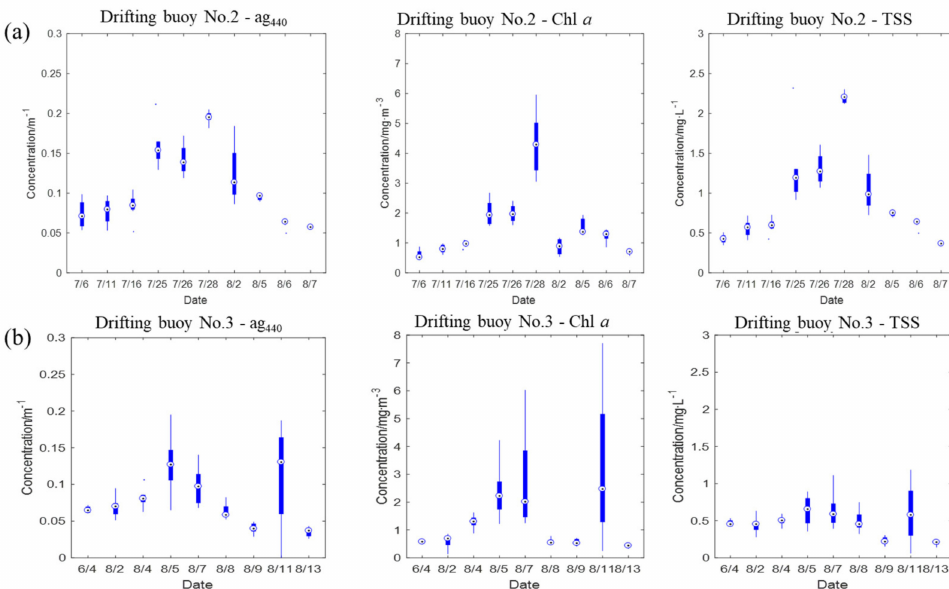
Figure 10. Multiday variation of buoys. No. 2 ( a ) and No. 3 ( b ). It shows the distribution characteris- tics and overall trends of multiday ag 440 , Chl a , and